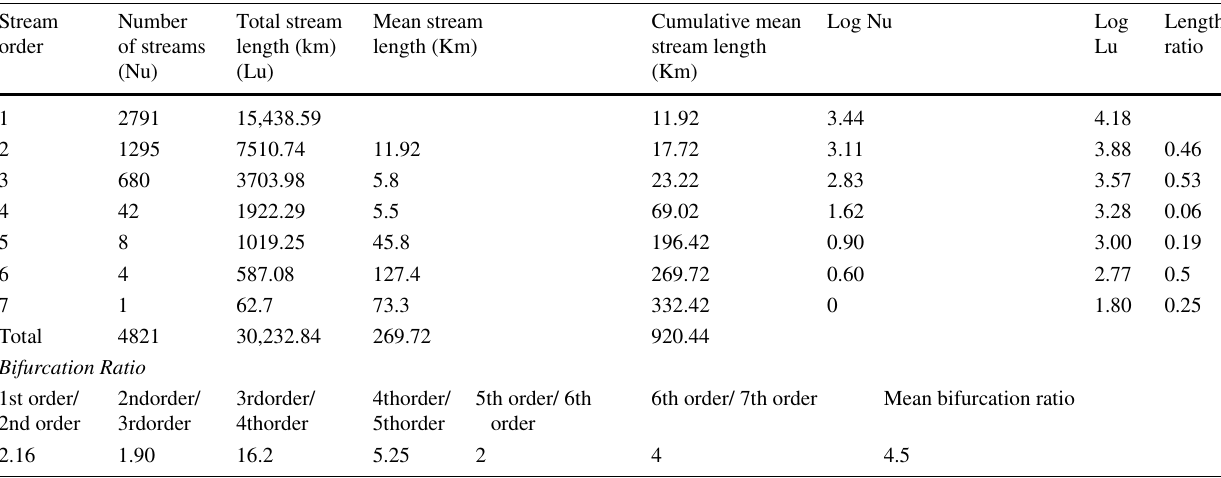
Table 4 Summary of Linear morphometric parameters of Upper Benue River Watershed Stream